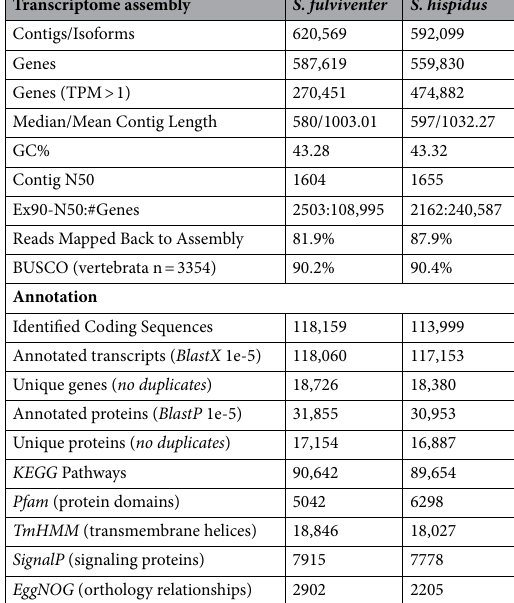
Table 1. De novo assembly and annotations